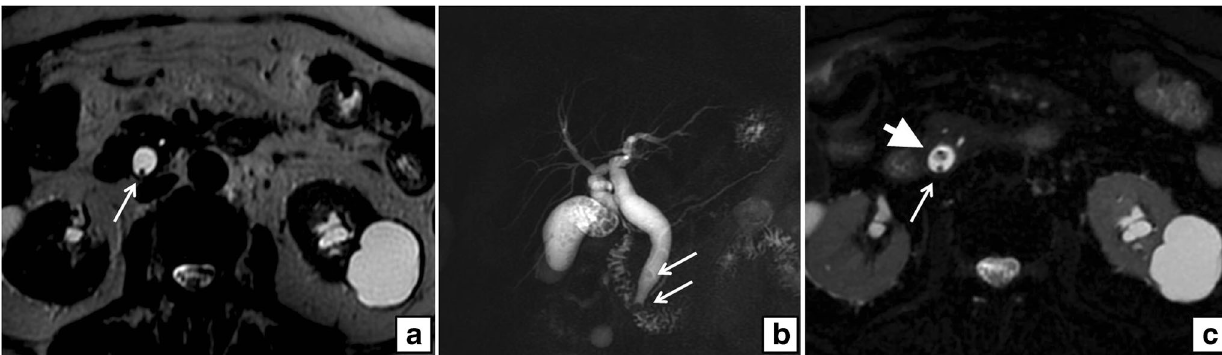
Fig. 3 a Axial T2-weighted MRI shows a millimetric filling defect in a dilated CBD ( arrow ). b Coronal MIP reformat of the same patient shows multiple filling defects in the gallbladder and two stones are seen in the